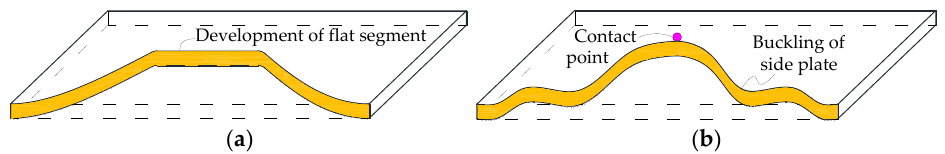
Figure 3. Buckling mode of flange plate under different conditions. ( a ) N x 0 < N cr . ( b ) N x 0 > N cr .